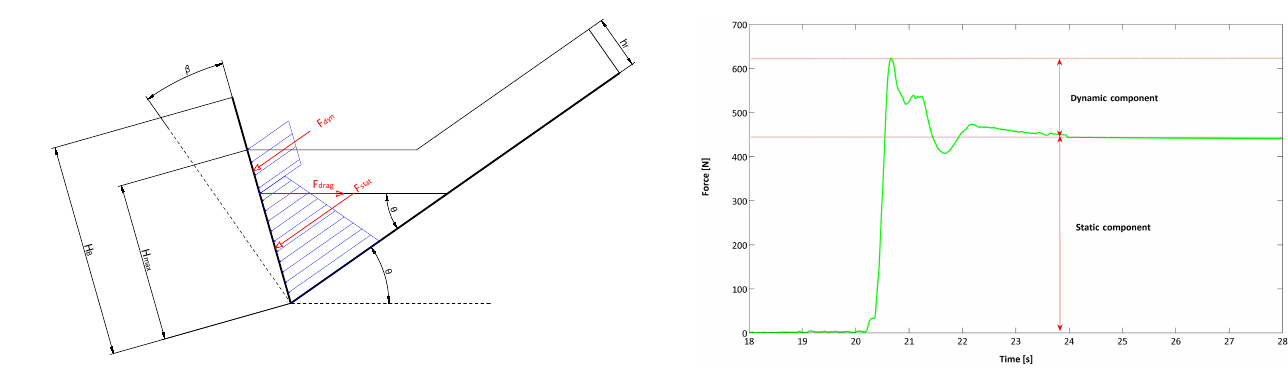
Figure 4. Scheme of flow impact and assumed filling process for the calculation of dynamic, static and drag load on the rigid barrier.